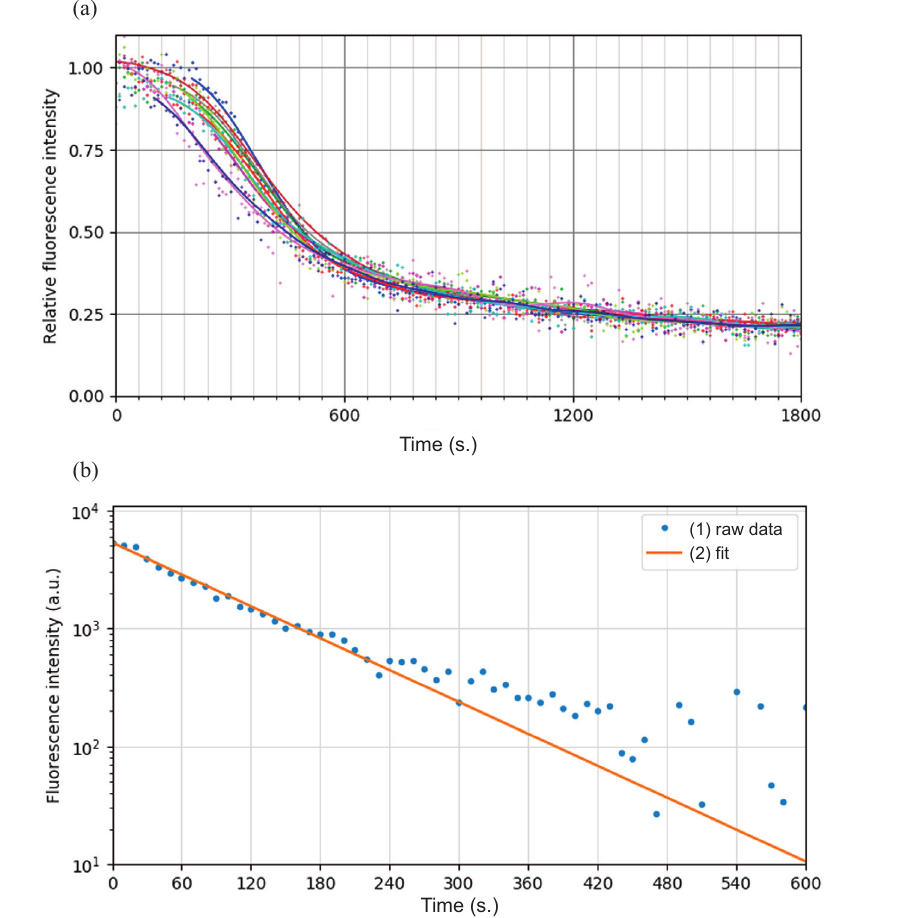
Fig. 5. Online monitoring result of tryptophan fluorescence peak intensity of B. atrophaeus spores, using the H2BM fluorometer is illustrated: (a) repeatability of HPV treatment at 600 ppm; (b) initial decrease in fluorescence peak intensity can be approximated by a single exponential decay function (to a plateau